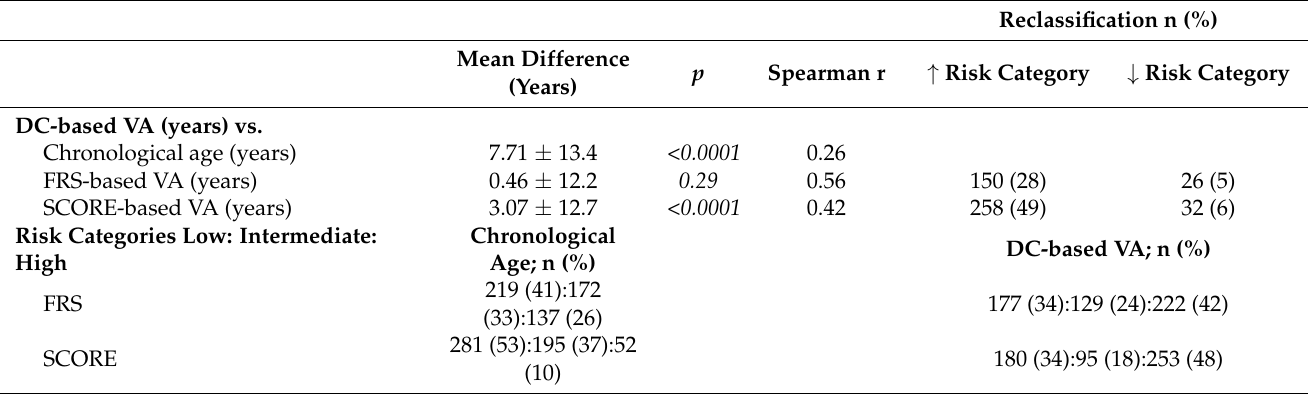
Table 2. Mean difference and correlation between DC-based vascular age, chronological age and risk-based vascular age and reclassification of risk with DC-based vascular age.